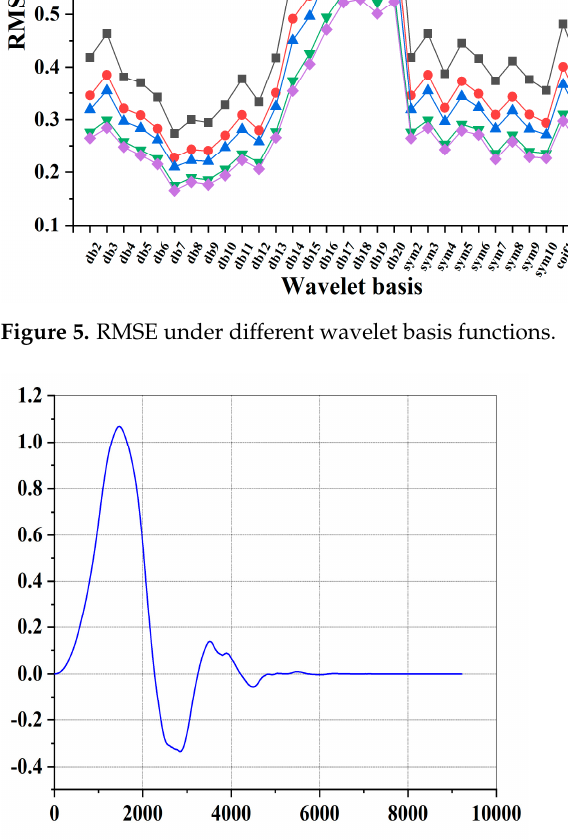
Figure 6. Scaling function.